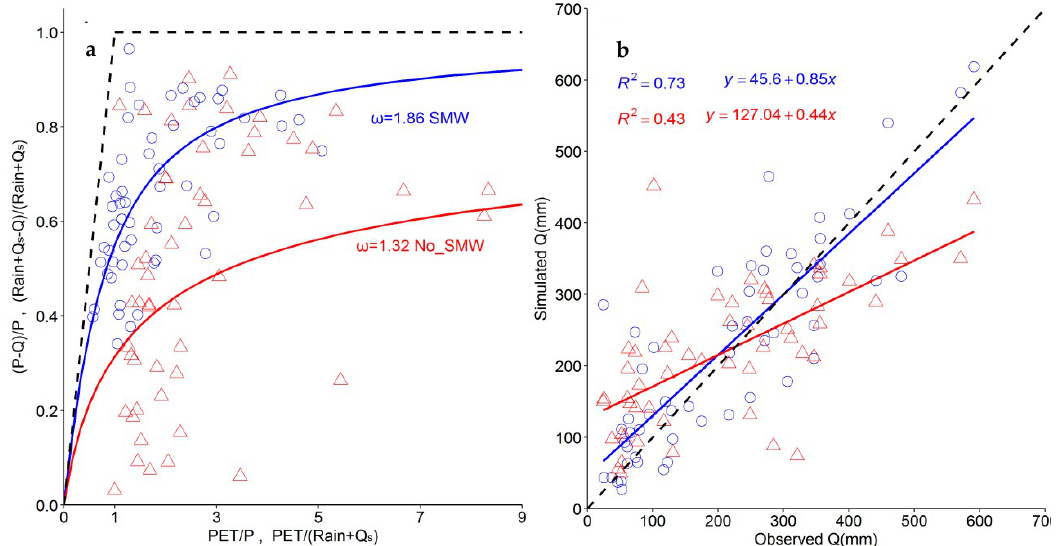
Figure 2. Impacts of snowmelt on Budyko curves ( a ) in 64 catchments of Xinjiang during 2000–2010 (results of the improved Budyko curves with the consideration of snowmelt water, blue dots; results of the original Budyko curves, red triangle), and the scatterplot of observed (Q) vs. simulated Q with meltwater including (blue circle) and meltwater excluded (red triangle) ( b ). Abbreviations: PET = potential evaporation; P = precipitation; Rain = rainfall; Q s = snow/glacier meltwater; Q = runoff; SMW = with snow/glacier meltwater; No_SMW = without snow/glacier meltwater.